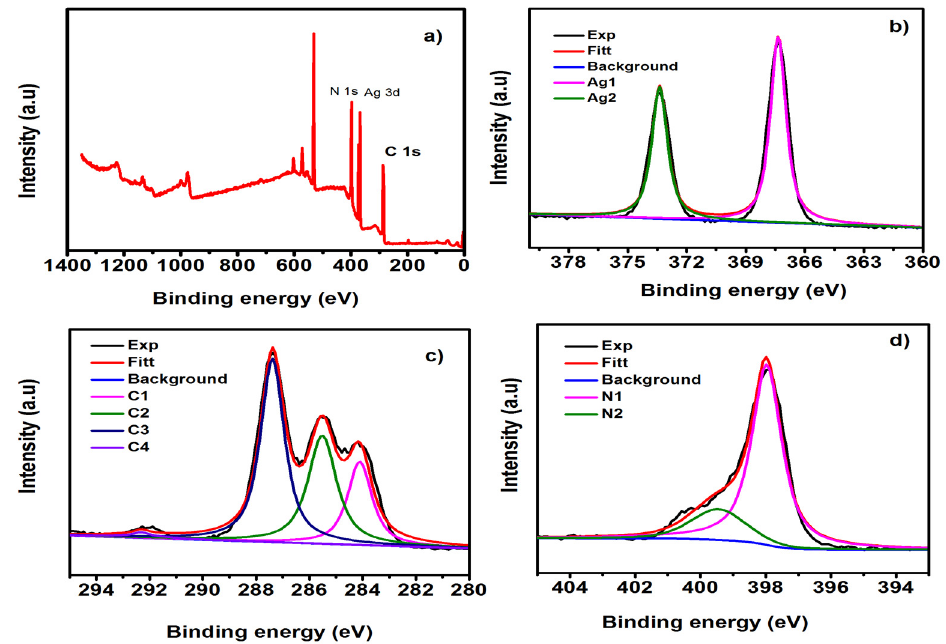
Figure 6. X-ray photoelectron spectra of 0.02 Ag/g-C 3 N 4 structures ( a ) survey scan, ( b ) Ag 3d, ( c ) C 1s, and ( d ) N 1s elements.